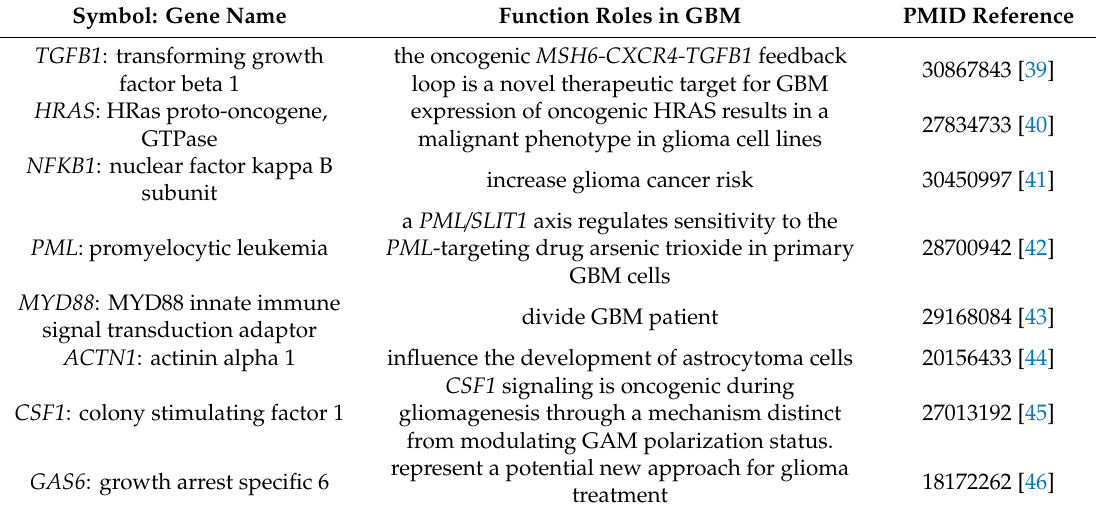
Table 2. The biological functions, corresponding PubMed IDs and literatures for genes with large topological changes between GBM and FHCN.